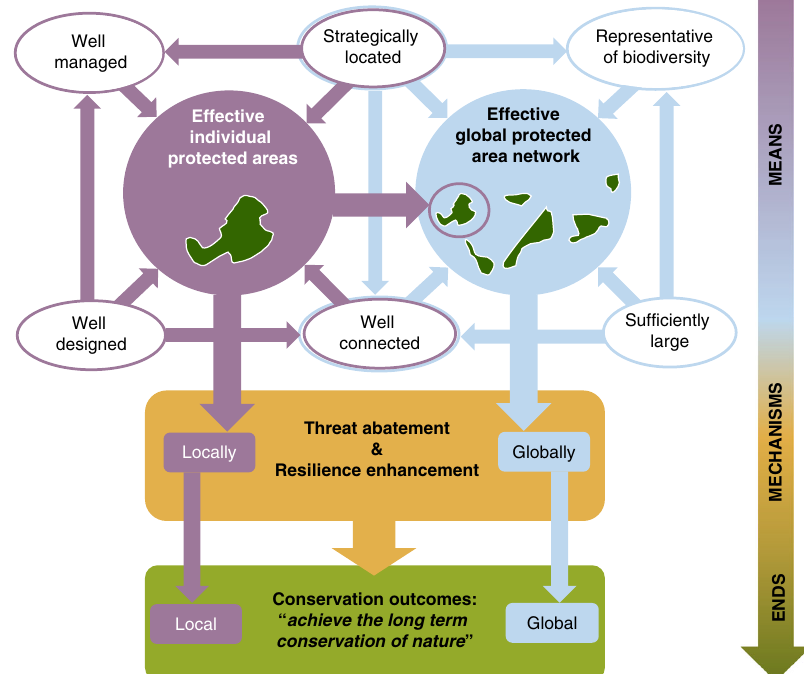
Fig. 1 The many facets of protected area effectiveness, from the means to the mechanisms, to the ends. Arrows indicate the direction of effects between elements (e.g., strategic location impacts